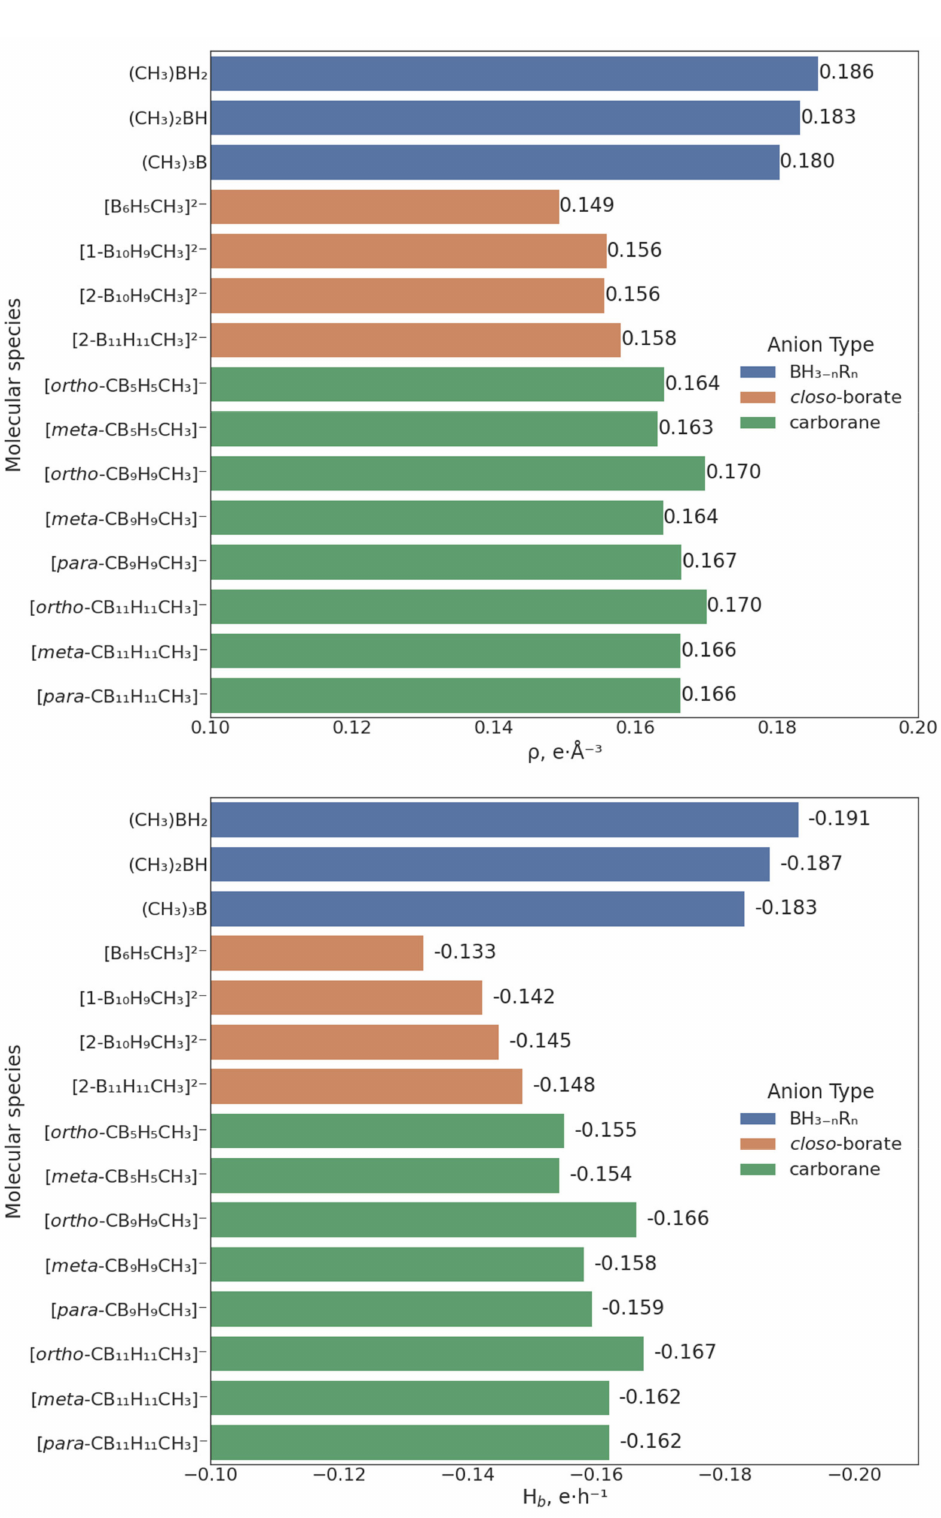
Figure 6. Values of electron density at bond critical point (bcp) p(r) and values of total energy at bond critical point (bcp) H b in closo-borate anions of the general form [B n H n − 1 CH 3 ] 2 − (n = 6, 10, 12), monocarboranes [CB n H n CH 3 ] − (n = 5, 9, 11) and BH 3 − n (CH 3 ) n (n = 1–3). For monocarboranes, only exo -polyhedral B–C bonds were